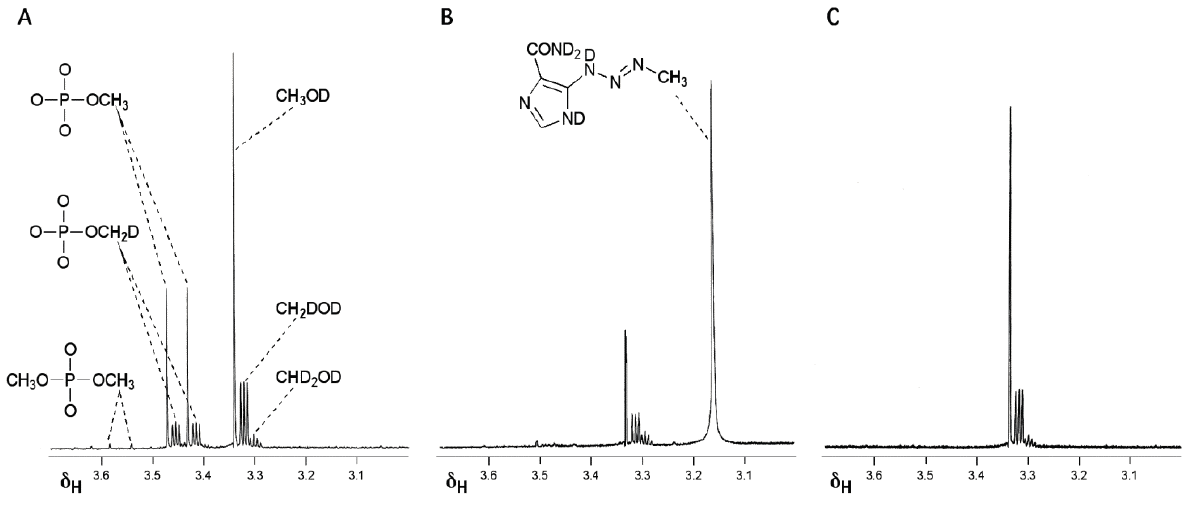
N in D O systems. ( A ) Products of reaction of 2 2 2 CO (10% in D O) showing the intact isotopic 2 3 2 CO (10% in D O) 2 3 2